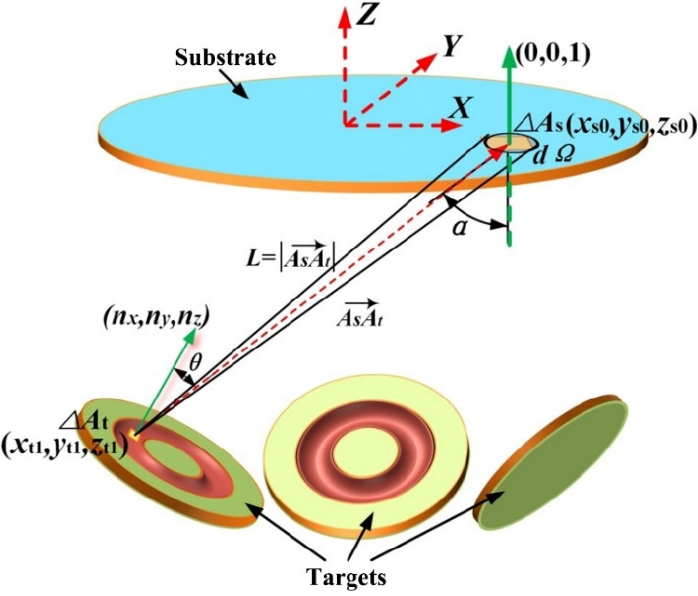
Figure 1. Geometric structure of triple-target magnetron co-sputtering system.